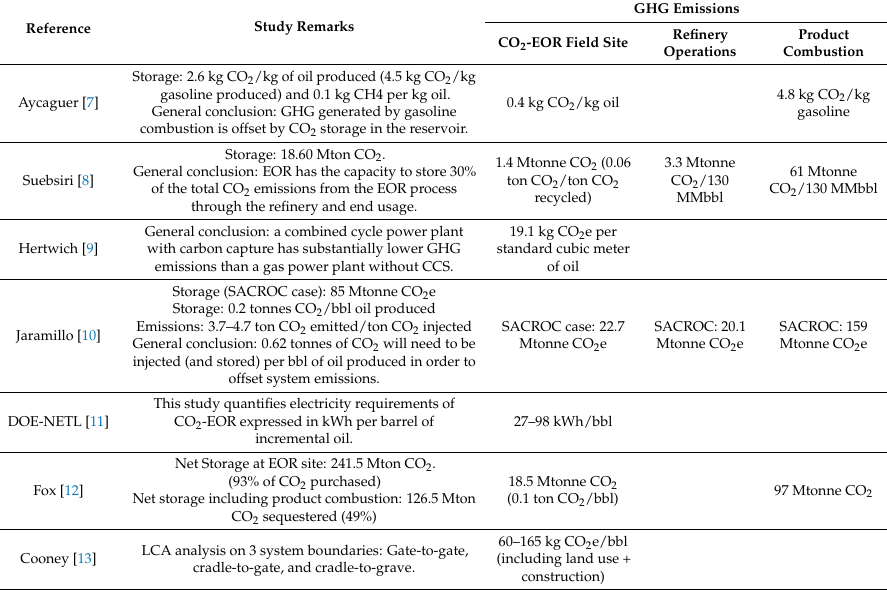
Table 1. Greenhouse gas (GHG) emissions from previous lifecycle analysis (LCA) studies on carbon dioxide-enhanced oil recovery (CO 2 -EOR), from oil field sites to end product